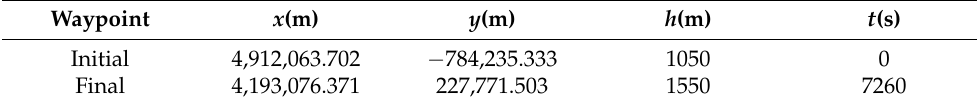
Table 2. Initial and final waypoints of the reference commercial